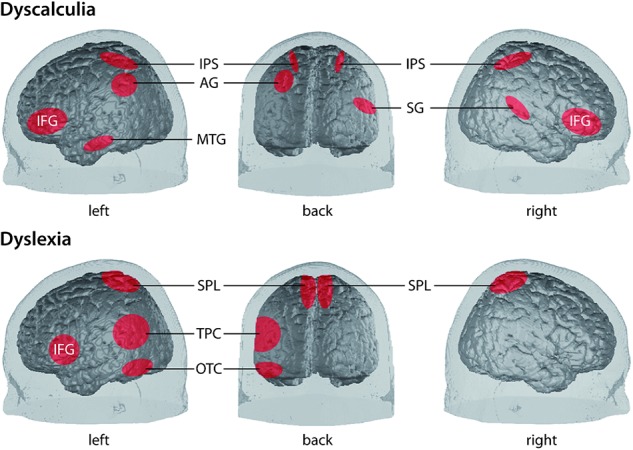
Simplified illustration of the location of involved cortical areas in the two LD dyscalculia [upper panel, from Bugden and Ansari (2015)] and dyslexia [lower panel, according to Richlan et al. (2009); Raschle et al. (2011) and Lallier and Carreiras (2017)]. AG, angular gyrus; IFG, inferior frontal gyrus; IPS, intraparietal sulcus; MTG, middle temporal gyrus; OTC, occipito-temporal cortex (comprising lateral extrastriate, fusiform, and inferior temporal regions); SG, supramarginal gyrus; SPL, superior parietal lobe; TPC, temporo-parietal cortex [comprising posterior superior temporal gyrus (STG), inferior parietal lobe].